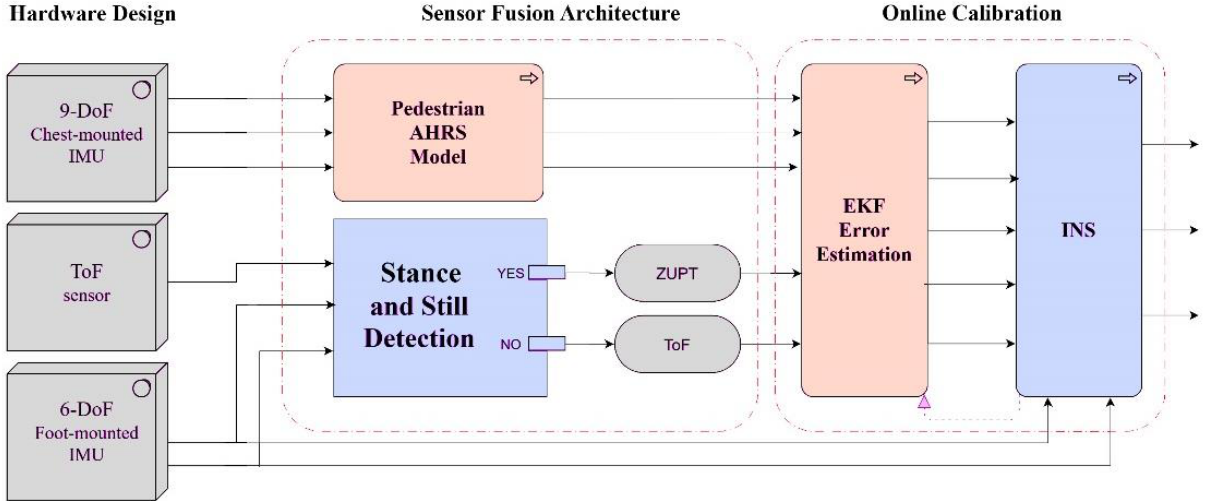
Figure 3. Multi-sensor fusion architecture and online calibration of indoor INS algorithm.